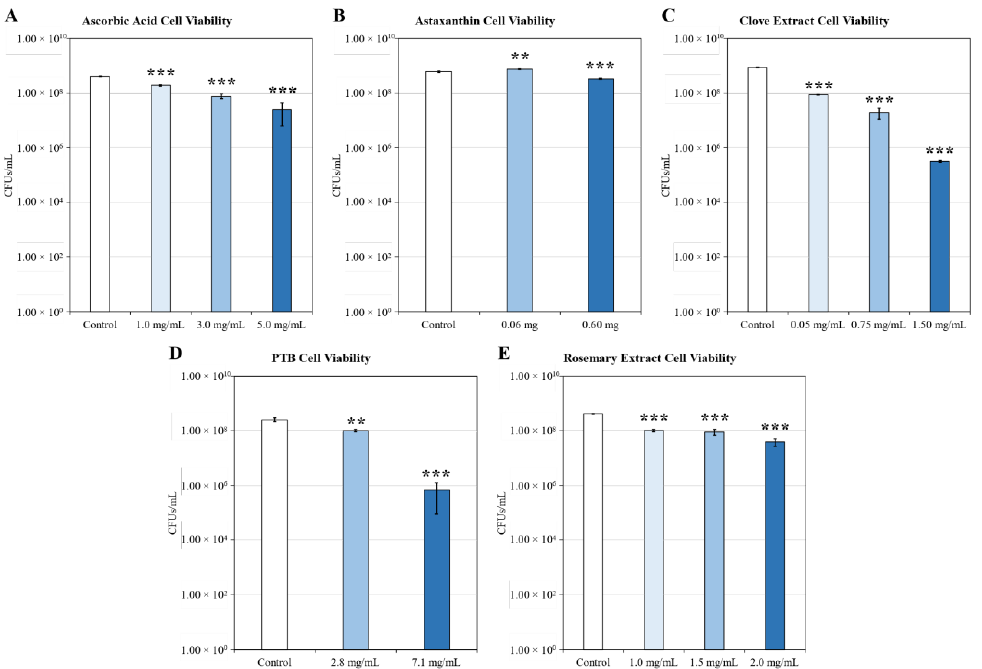
Figure A2. Cell Viability. S. aureus cell viability after 24 h of incubation under planktonic conditions with additives. ( A ) Ascorbic acid, ( B ) Astaxanthin, ( C ) Clove extract, ( D ) PTB, ( E ) Rosemary extract. n = 3. Mean ± Standard Deviation. Statistical difference determined by Student’s t -test compared to control. ** p <0.01, *** p < 0.001.